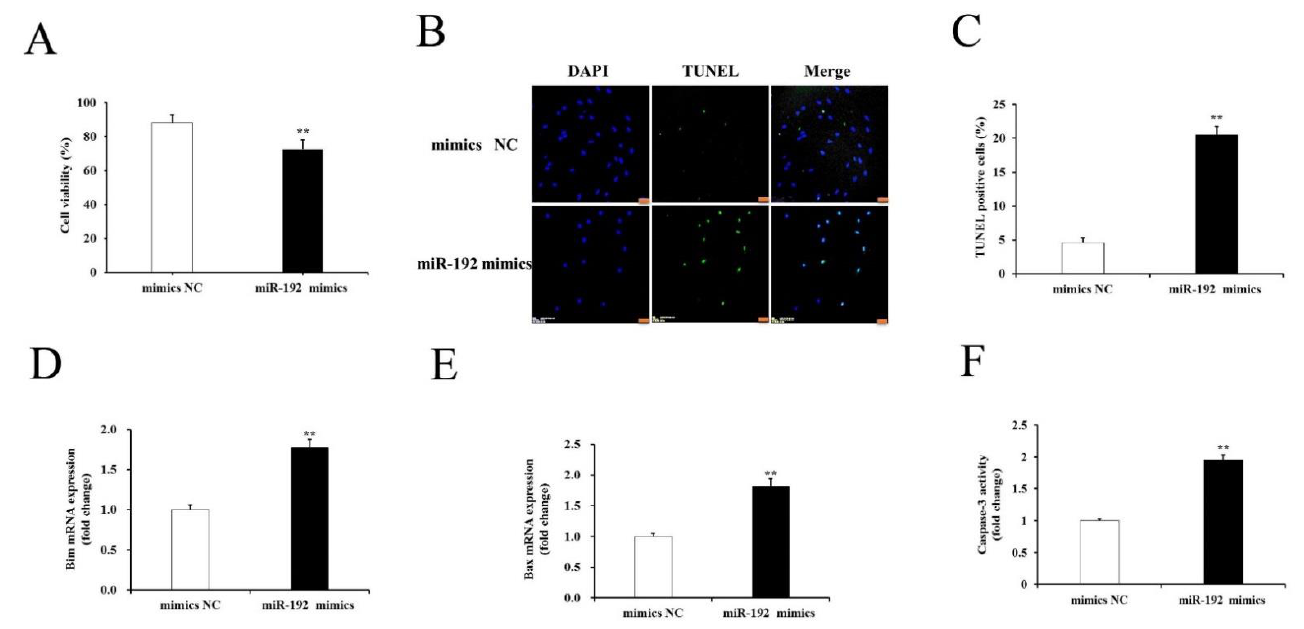
Figure 7. Overexpression of miR-192 induces PGCs apoptosis. ( A ) Effects of miR-192 overexpression on the proliferation of PGCs. ( B ) Apoptosis of GCs was evaluated using TUNEL assay; scale bars correspond to 50 μm. ( C ) Quantification of TUNEL-positive cells in porcine GCs. ( D ) The expression analysis of Bim . The relative expression data were normalized to β -actin. ( E ) The expression analysis of Bax. ( F ) The analysis of caspase-3 activity. The t-test was used to examine the differences between the groups. Data are presented as the means ± SE. ( n = 3). ** p < 0.01.